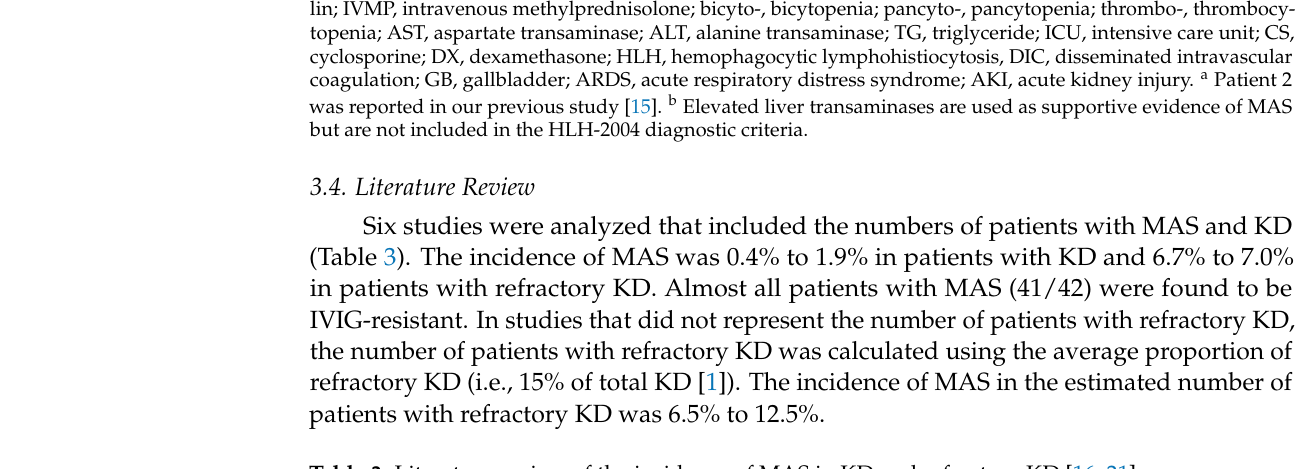
Table 3. Literature review of the incidence of MAS in KD and refractory KD